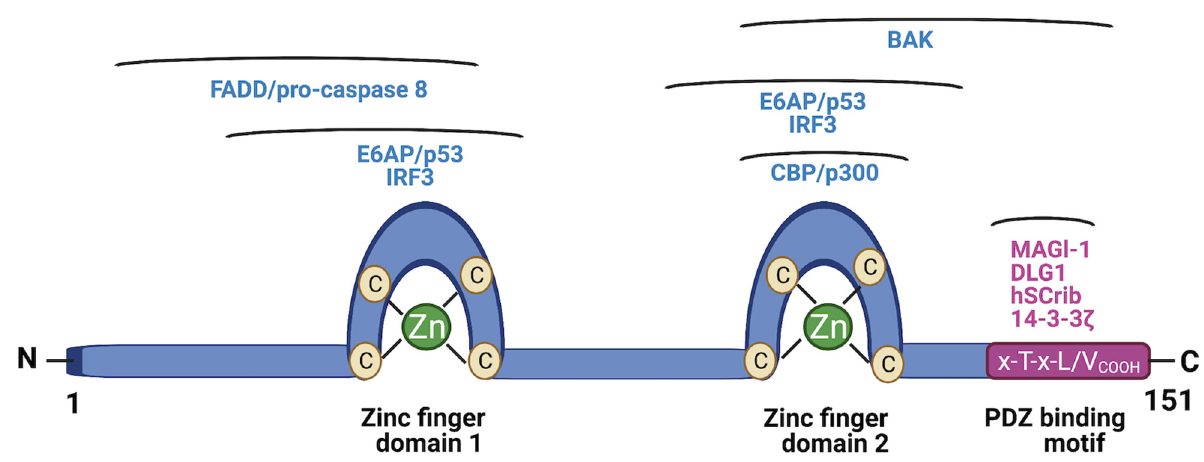
Figure 1. Schematic structure of HPV E6. Two zinc finger domains of E6 are shown, together with regions that are involved in interacting with the cellular substrates indicated above the regions. At the C-terminus is the PDZ-binding motif (PBM) and the associated PDZ proteins that bind to it. (Figure created using Biorender).